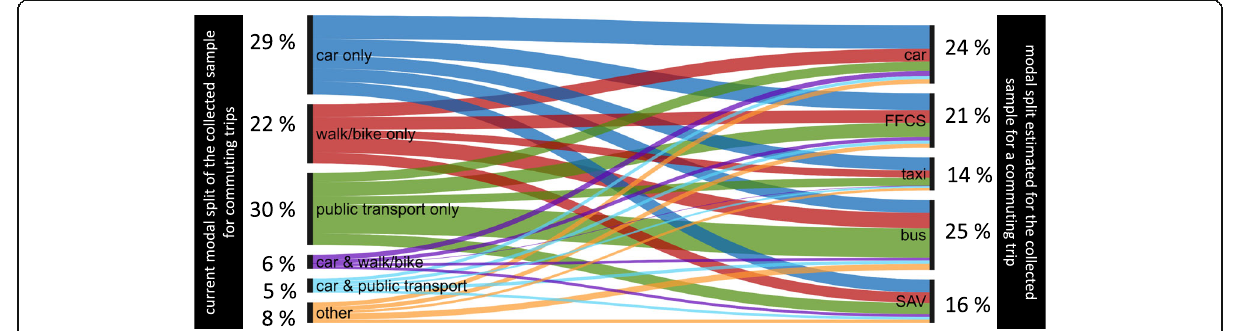
Fig. 4 Estimated mode migration patterns: current (left) and estimated (right) market shares per commuting